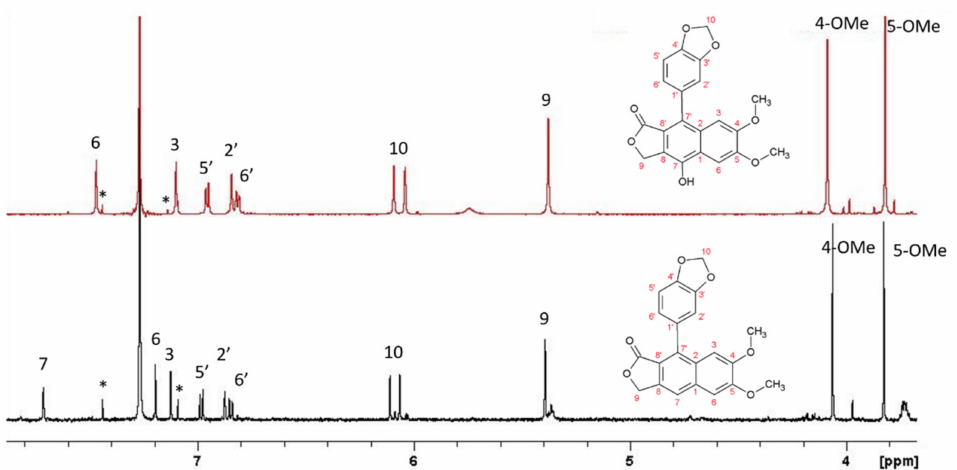
Figure 3. 1 H-NMR spectra recorded at 600MHz of TLC-purified extracts from L. austriacum cell cultures containing JU ( bottom ) and DI ( top ) in CDCl 3 solution. Resonance assignment is reported for clarity. Asterisks indicate 13 C satellite signals of the